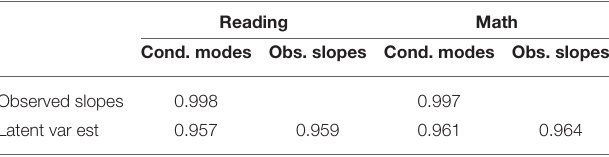
TABLE 5 | The different approaches to growth modeling for estimating the slope estimates for Math Maps and Reading Maps for fall, winter, and spring.